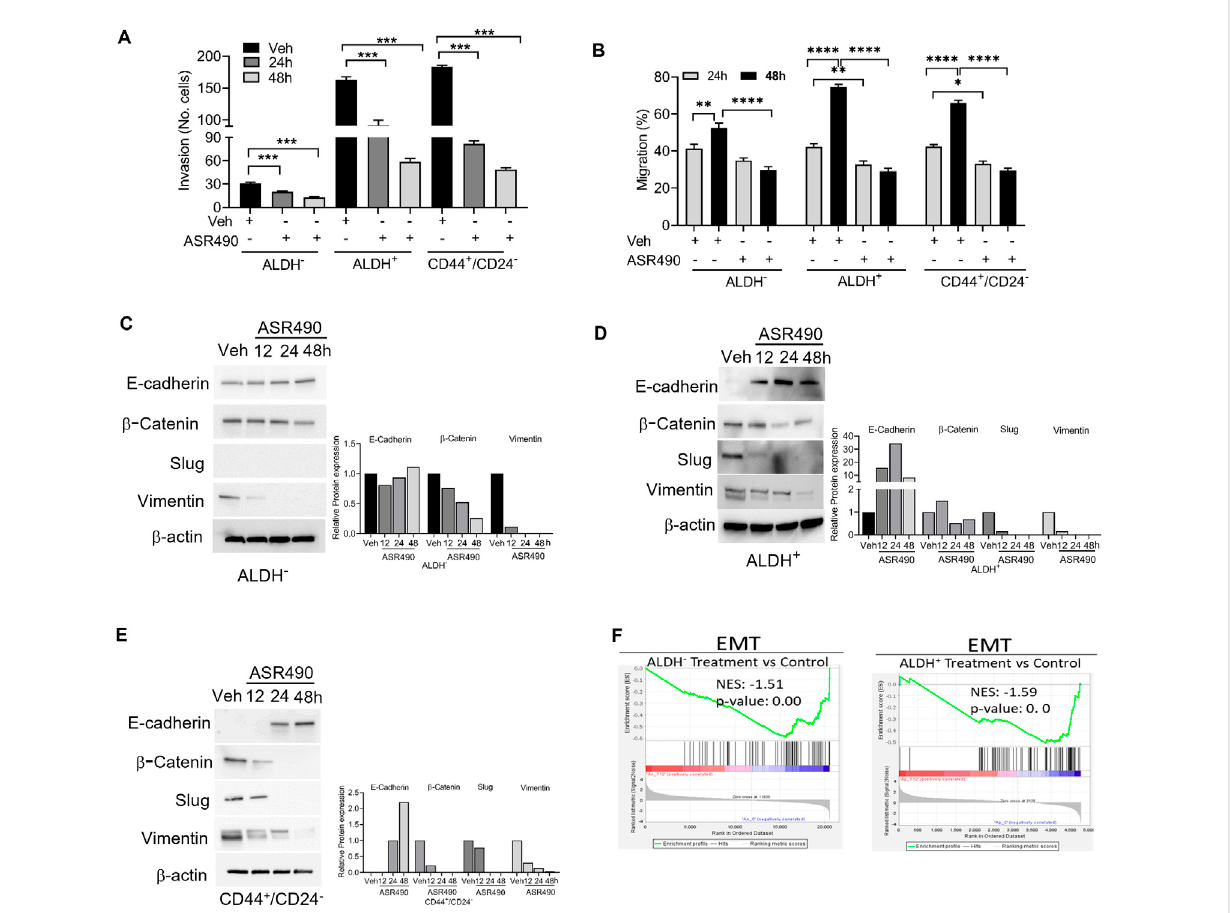
FIGURE 7 ASR490 inhibits the invasive and migratory abilities of BC and BCSCs. (A) Boyden chamber invasion assay was used to assess the time-dependent effectsofASR490 ontheinvasive abilityofALDH − ,ALDH + ,andCD44 + /CD24 − cells ( n =3,**** p < 0.0001). (B) Time-dependenteffectsofASR490onthe migratory abilities of ALDH − , ALDH + and CD44 + /CD24 − cells were assessed using a scratch wound assay ( n = 3, * p < 0.03, ** p < 0.007 and **** p < 0.0001). p values are based on one-way ANOVA with post hoc Tukey ’ s test. (C – E) Western blots showing time-dependent effects of ASR490 treatment on EMT markers (E-Cadherin, β -Catenin, Slug, and Vimentin) in ALDH − , ALDH + , and CD44 + /CD24 − cells. (F) GSEA of RNA-seq data demonstrating downregulation of EMT-regulated genes in ASR490-treated ALDH − and ALDH +